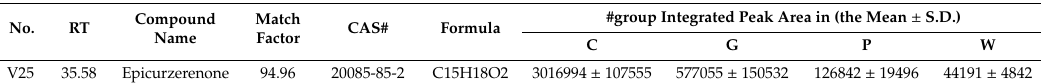
Table 2. Quality marker identification and the integrated peak area in the crude and the processed Curcuma zedoaria.